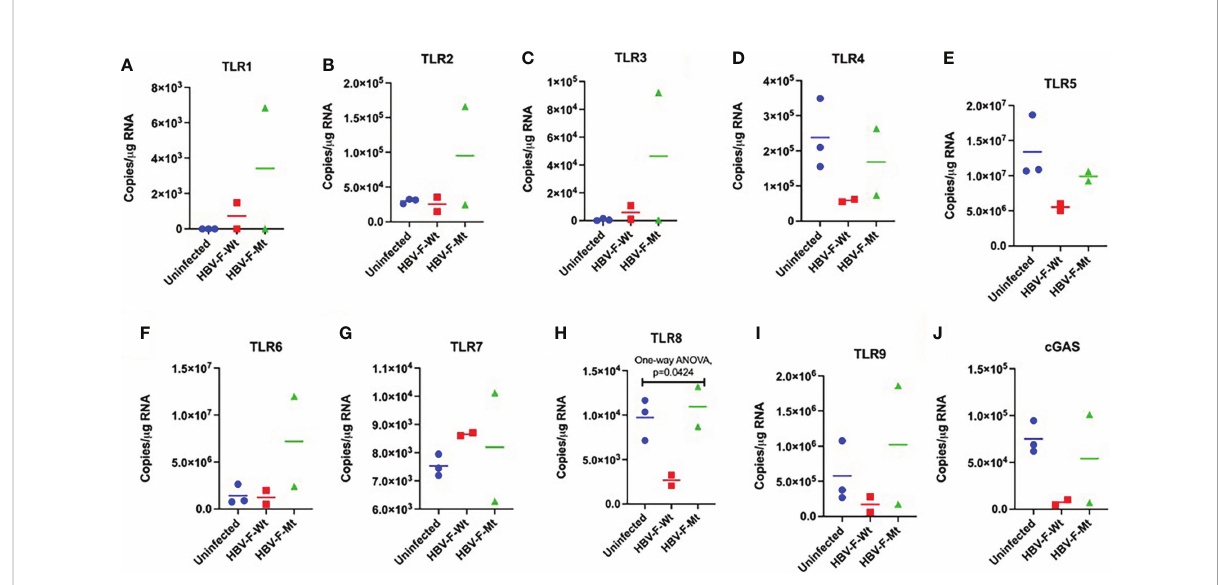
FIGURE 2 Intrahepatic TLR responses to acute HBV-F Wt/Mt infection in tree shrews. Intrahepatic expression of (A-I) TLR1 – 9 mRNA in uninfected control (#5, 38 and 53), HBV-F Wt (#149 and 192)/Mt (#178 and 191)-infected tree shrews at 14 dpi. (J) cGAS mRNA expression in uninfected control and HBV-F Wt/Mt-infected tree shrews at 14 dpi. We performed the statistical analysis, and the P values are shown if they are statistically signi fi cant. Thick horizontal lines indicate arithmetic mean.